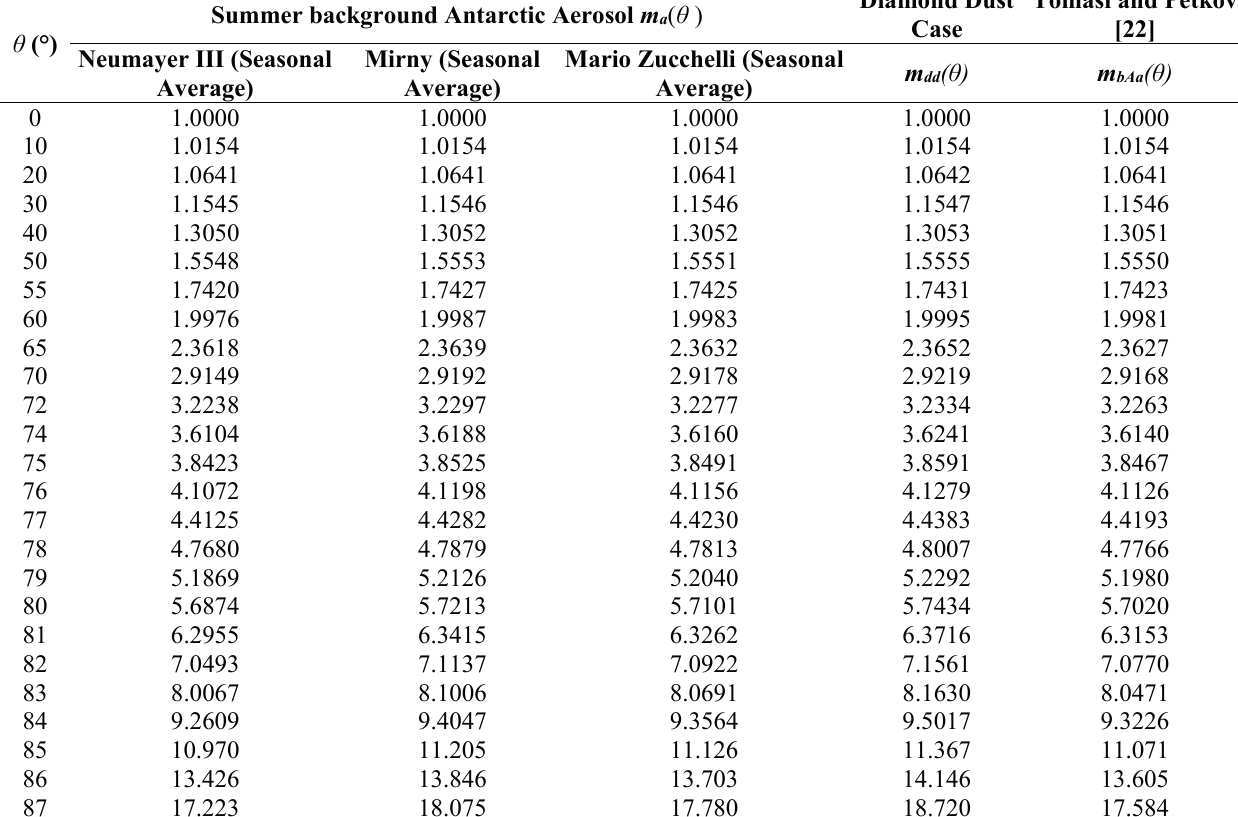
Table 3. Values of the relative optical air mass functions m a ( θ ) calculated for 25 selected values of apparent solar zenith angle  θ ranging from 0° to 87°, as obtained in the present study for background summer Antarctic aerosol used as weight functions in Equation (3) the average vertical profiles of k a ( z ) shown in Figure 3b for Neumayer III, Mirny and Mario Zucchelli, as obtained by averaging the CALIPSO data collected during the summer months from November to February of the last 2 years, and values of the relative optical air mass functions m dd ( θ ) calculated for diamond dust particles obtained for the average vertical profile of k a ( 0.532  m ) shown in Figure 4 for a diamond dust ground layer observed at Dome C on 7 February 2008 (00:40 UTC) using the INO-CNR Antarctic lidar. The present results are compared with the TP2014 [22] evaluations of relative optical air mass function m bAa ( θ ) determined at Mario Zucchelli for background Antarctic aerosol in austral summer, which are reported in the last column for